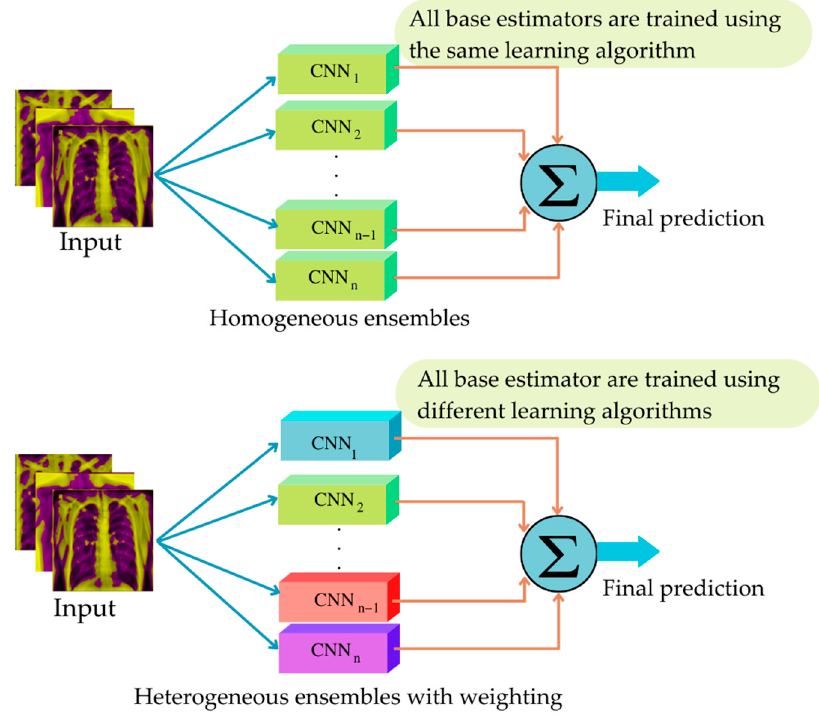
Figure 10. Structure of the EDL using heterogeneous and homogenous manners.